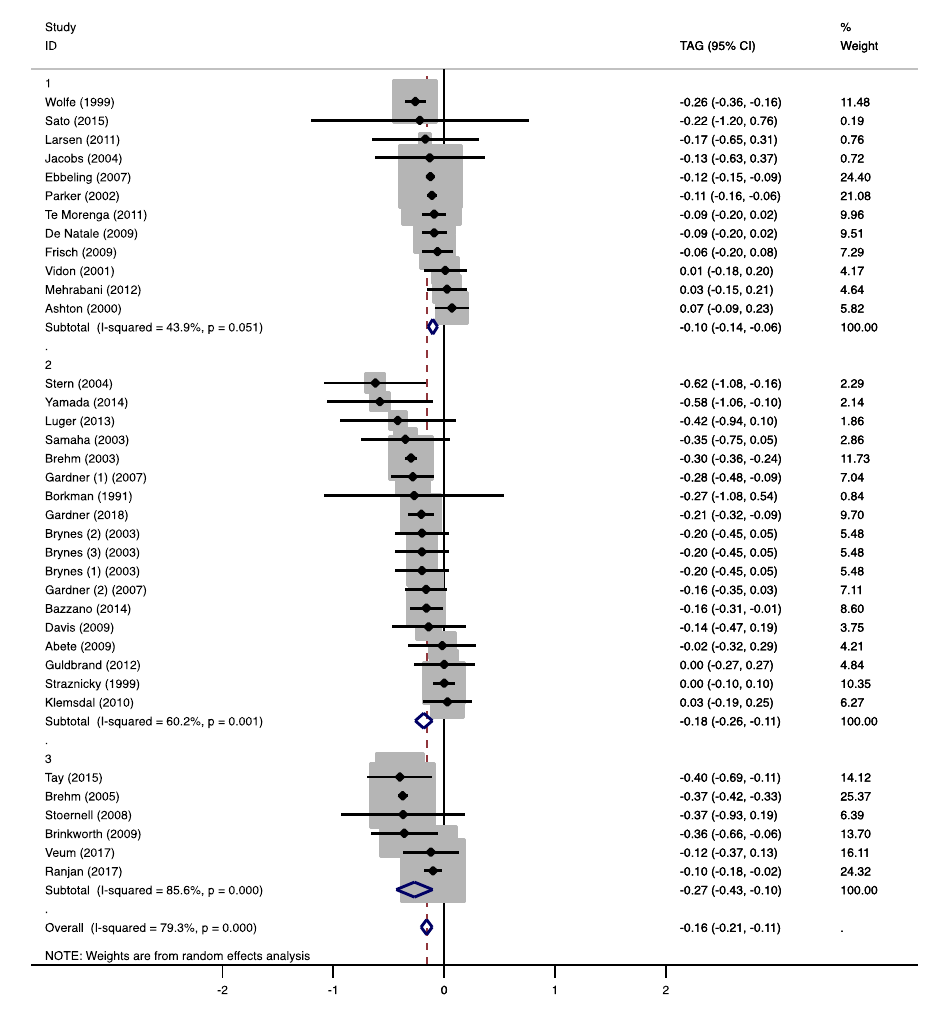
Figure 4. Forest plots of randomized controlled trials that examined the effects of carbohydrate (CHO) restriction on triacylglycerol (TAG) concentrations. Studies were categorized in group 1 (moderate-low CHO, 40–45 E%), group 2 (low CHO, 40–30 E%), and group 3 (very-low CHO, 30–3 E%). Solid squares represent the weight of individual studies and diamonds represent the weighted mean di ff erence (WMD) in TAG. E ff ects were calculated using random-e ff ect meta-analysis. Decreases in TAGs were significantly lower in the low and very-low CHO group compared to the moderate-low CHO group. The moderate-low CHO diets did not a ff ect glucose (0.05 mmol / L, 95% CI − 0.22 to 0.31 mmol /